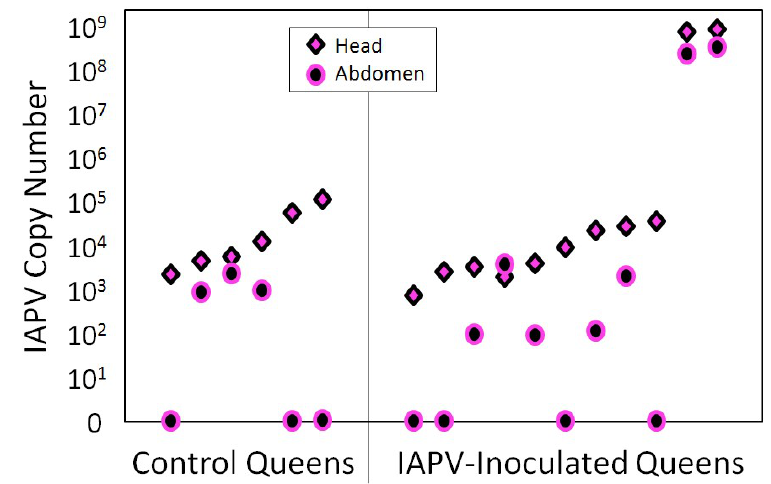
Figure 3. IAPV infection of the experimental queens after the conclusion of the experiment. IAPV was detected by RT-qPCR in all queens of the IAPV-inoculated and of the sham-treated control group, with no significant difference in IAPV quantities between treatment groups, although two of the IAPV-inoculated queens (right) had titers that were three orders of magnitude higher than the other queens.